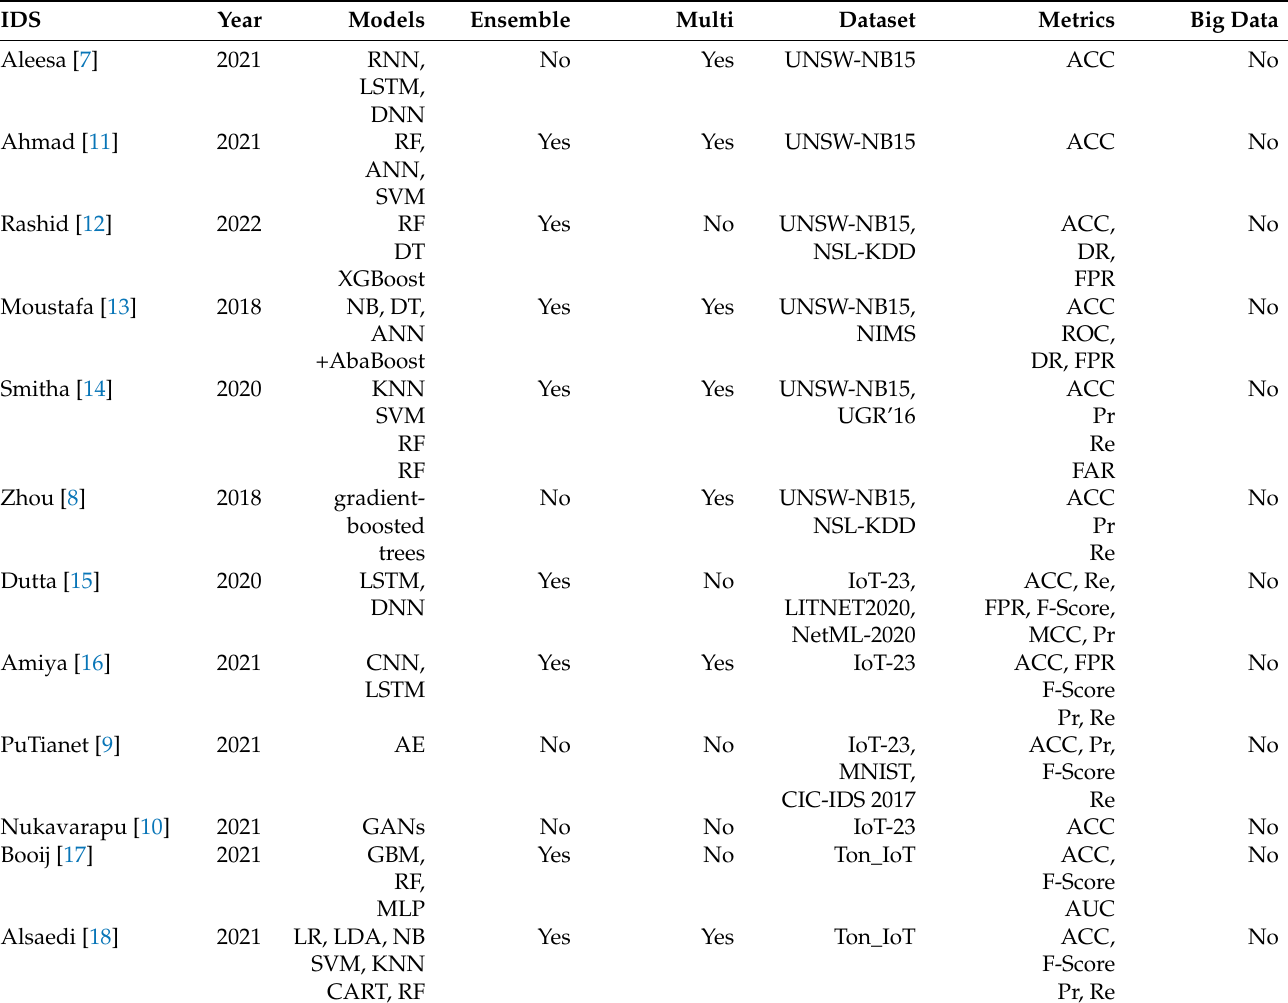
Table 1. A comparison and Summary of the literature